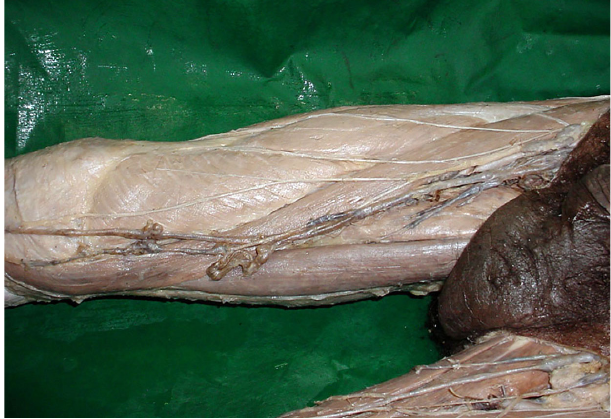
Fig. 1 – Dissected great saphenous